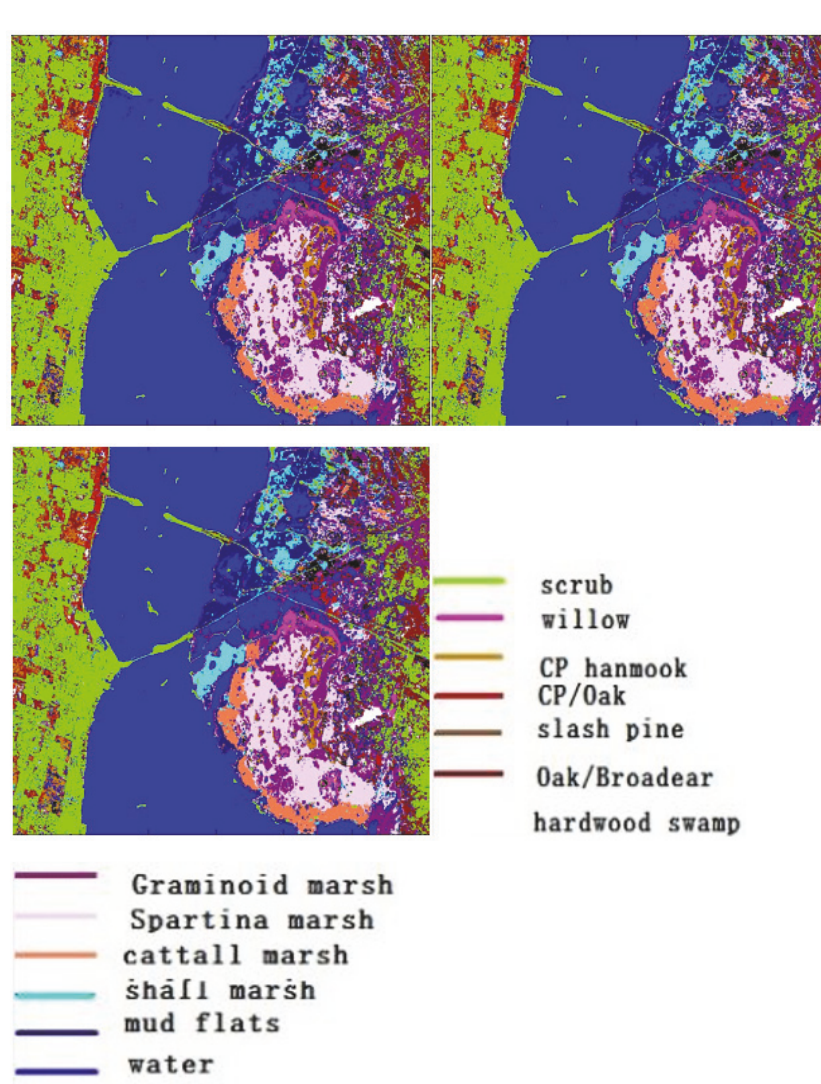
Figure 17: The classification results in the initial 5% label conditions of the algorithm for AVIRIS